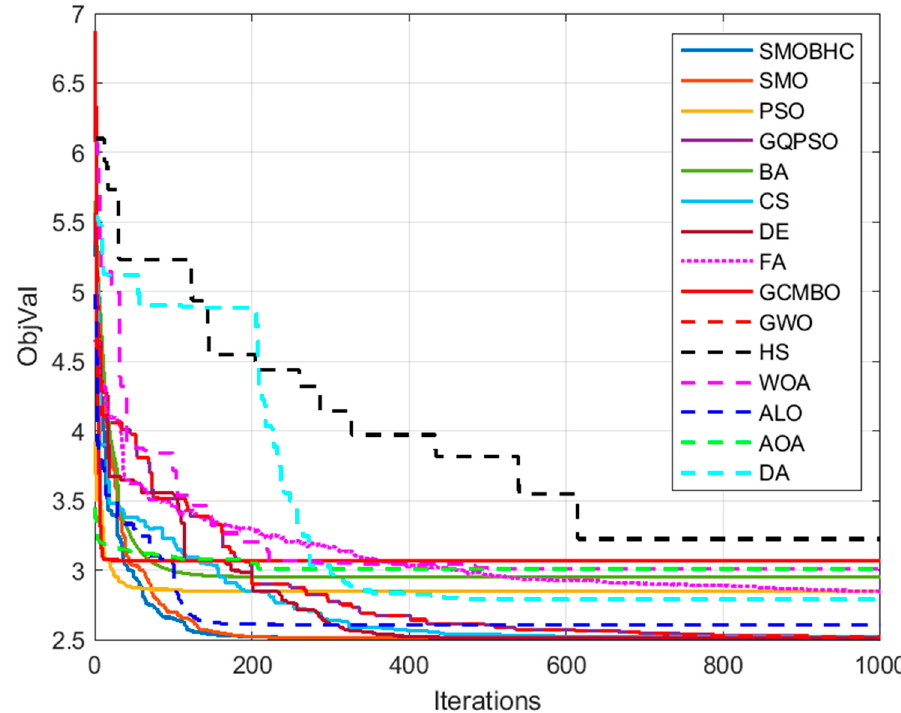
Figure 13. Comparative convergence curves of algorithms for battlefield 2 with 𝐷 = 30 .